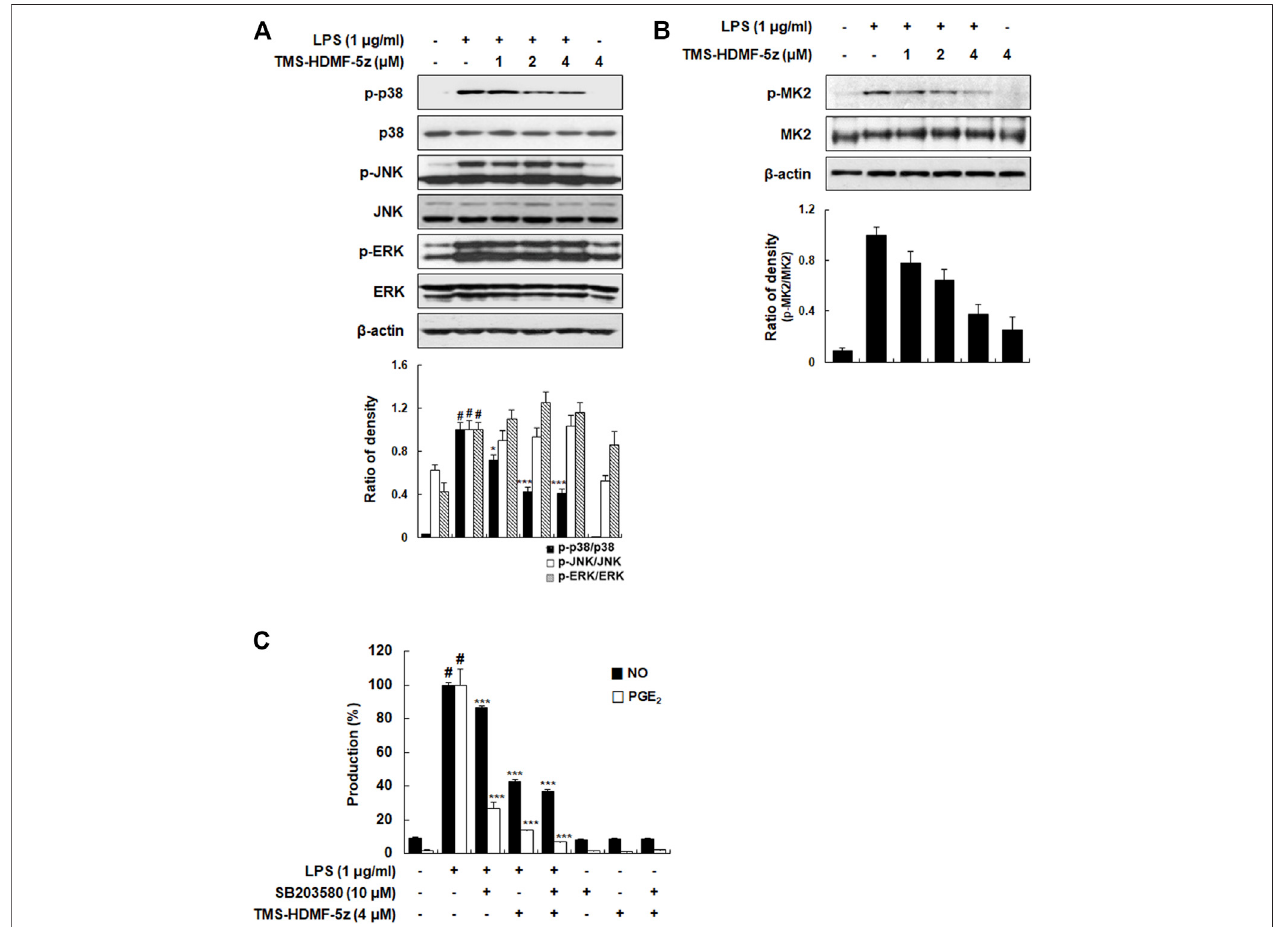
FIGURE 5 | Inhibitory effects of TMS-HDMF-5z on p38 MAPK signaling pathway in LPS-stimulated RAW 264.7 macrophages. (A,B) The expression of p-p38 MAPK,p38 MAPK, p-JNK, JNK, p-ERK, ERK, p-MK2, and MK2 were detected by western blotting. The relative optical density ratio vs . ß -actin wasdetermined using a densitometric analysis program (Bio-Rad Quantity One Software, version 4.6.3 (Basic), Bio-Rad Laboratories Inc., CA, United States), normalized tothe internal control. (C)